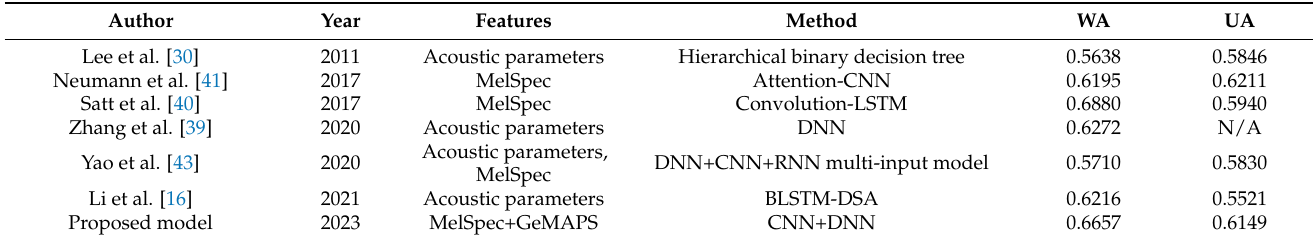
Table 2. Comparison with state-of-the-art